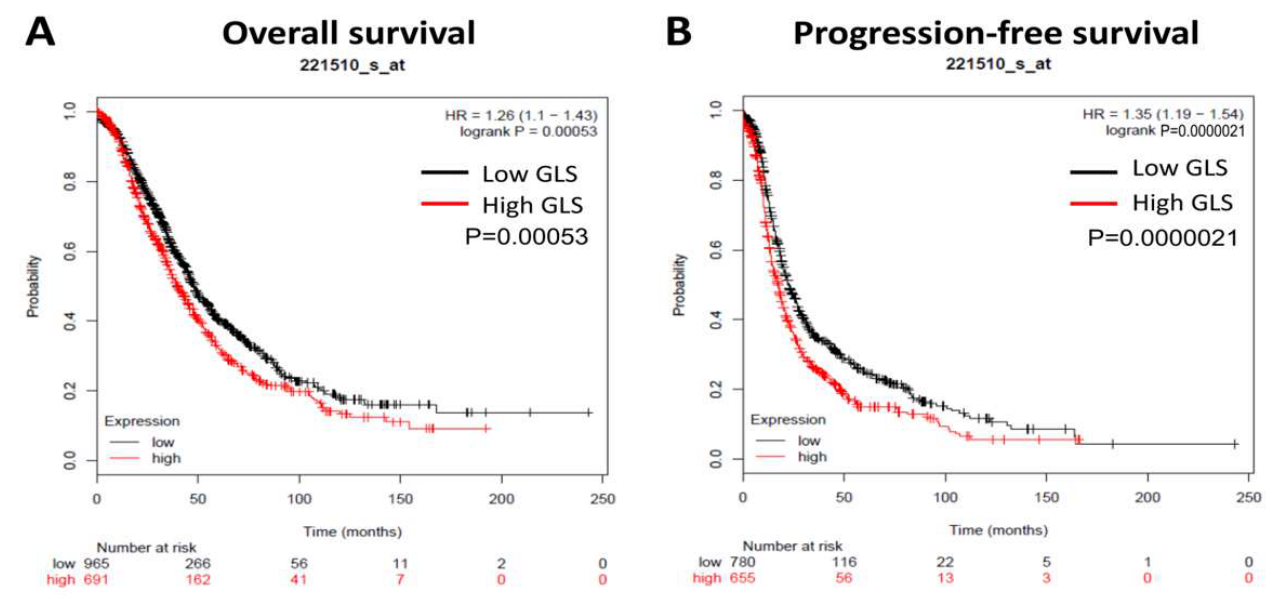
Figure 1. Upregulation of GLS predicts poorer overall/progression-free survival. Kaplan–Meier analysis usign the Kaplan– Meier plotter dataset from ovarian cancer patients (including all tumor stages, grades and histological subtypes) showed that GLS expression correlates with poorer overall survival ( A ) and progression-free survival ( B ).